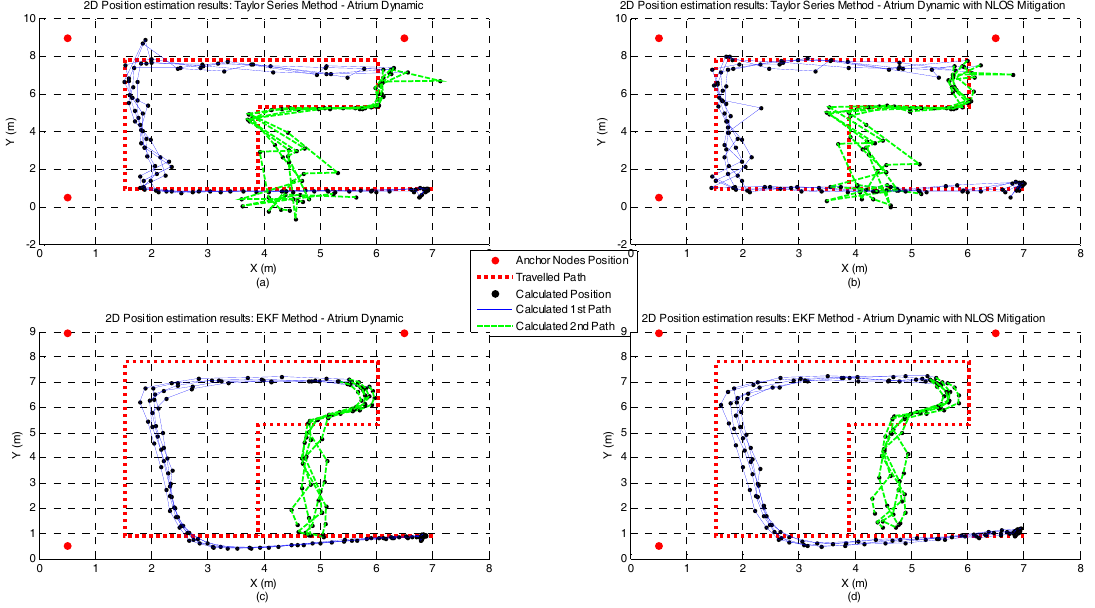
Figure 11. Atrium Dynamic test with Taylor Series ( a , b ) and EKF ( c , d ) methods and with and without NLOS identification and mitigation.